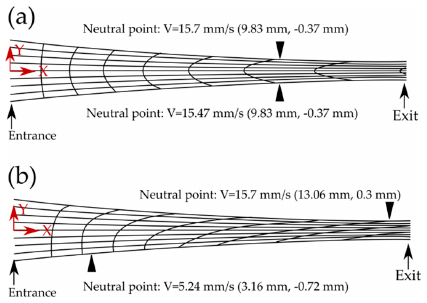
Figure 7. Comparison of grid distortions and neutral points: ( a ) ESR and ( b ) HRDSR [45]. Reproduced with permission from Ji et al., Mater. Sci. Eng. A ; published by Elsevier, 2007.